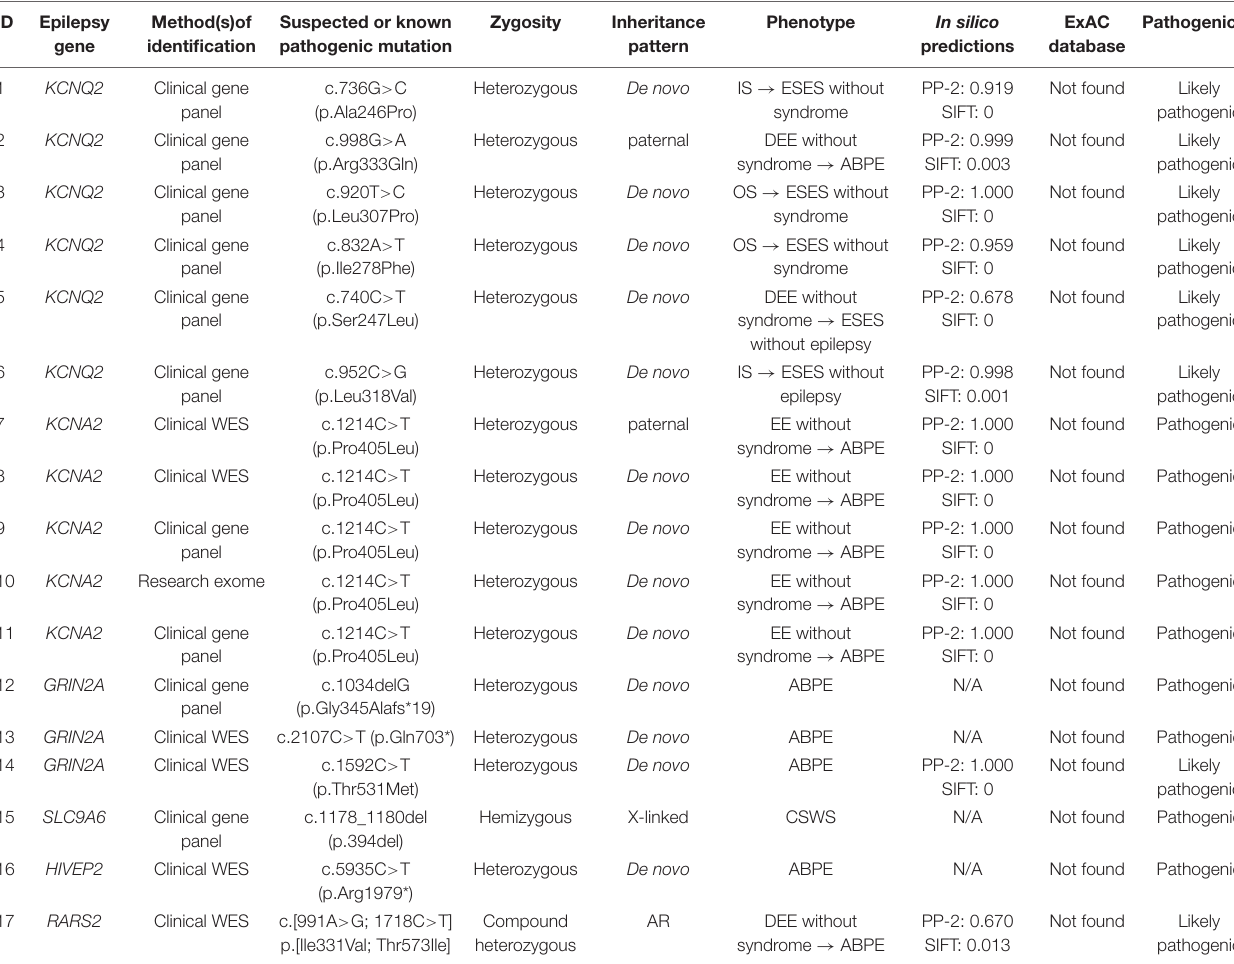
TABLE 1 | Summary of monogenic variants for a series of 17 cases of DEE/EE with ESES. ID Epilepsy Method(s)of Suspected or known gene identification pathogenic